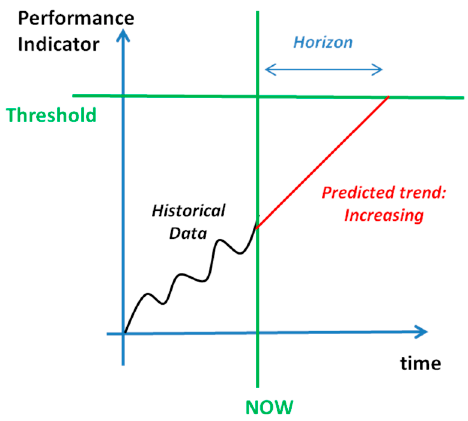
Figure 3. Alarm that is created by prediction of KPI exceeding threshold.